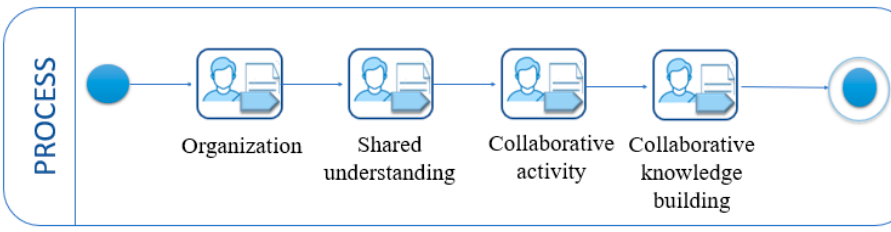
Figure 3. Workflow of process activities.